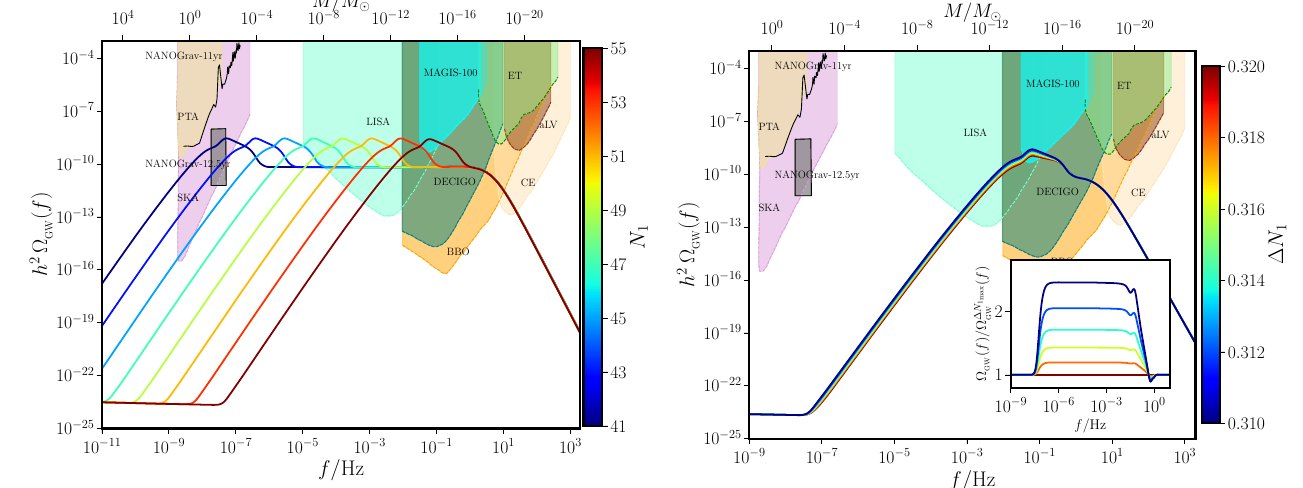
( f ) that arise in the recon- GW ( f ) . In contrast, the GW ( f ) GW 10 − 8 . This value ×